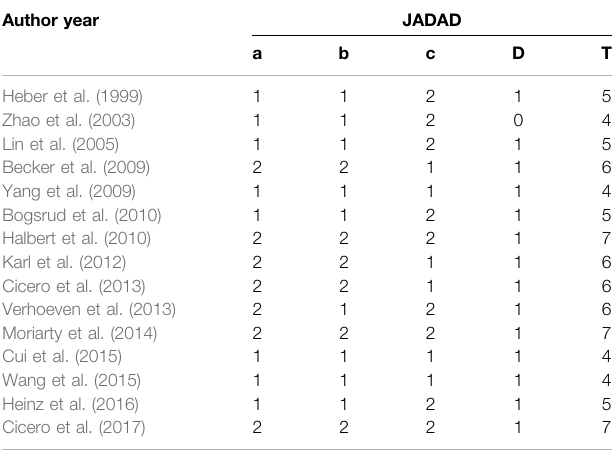
TABLE 2 | Jadad scale of the included